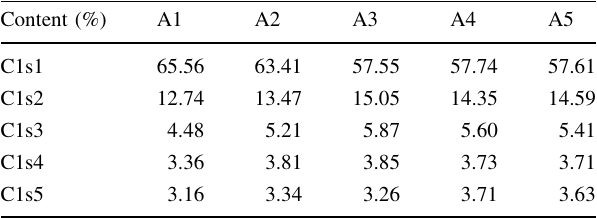
Table 5 Distribution of the five forms of the samples Content (%)